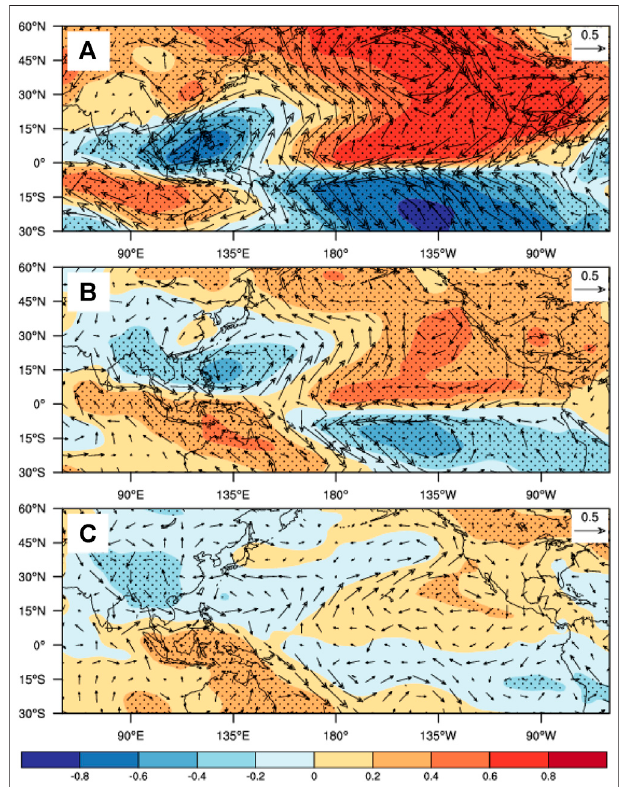
FIGURE 10 | The correlation coef fi cients between the sign-reversed Niño3 index in January – March and the 850 hPa stream function anomaly (shading) and rotational wind anomaly (vector) in (A) January – March, (B) April – June and (C) July – September. The dotted areas indicate the correlations that are signi fi cant at the 90% con fi dence